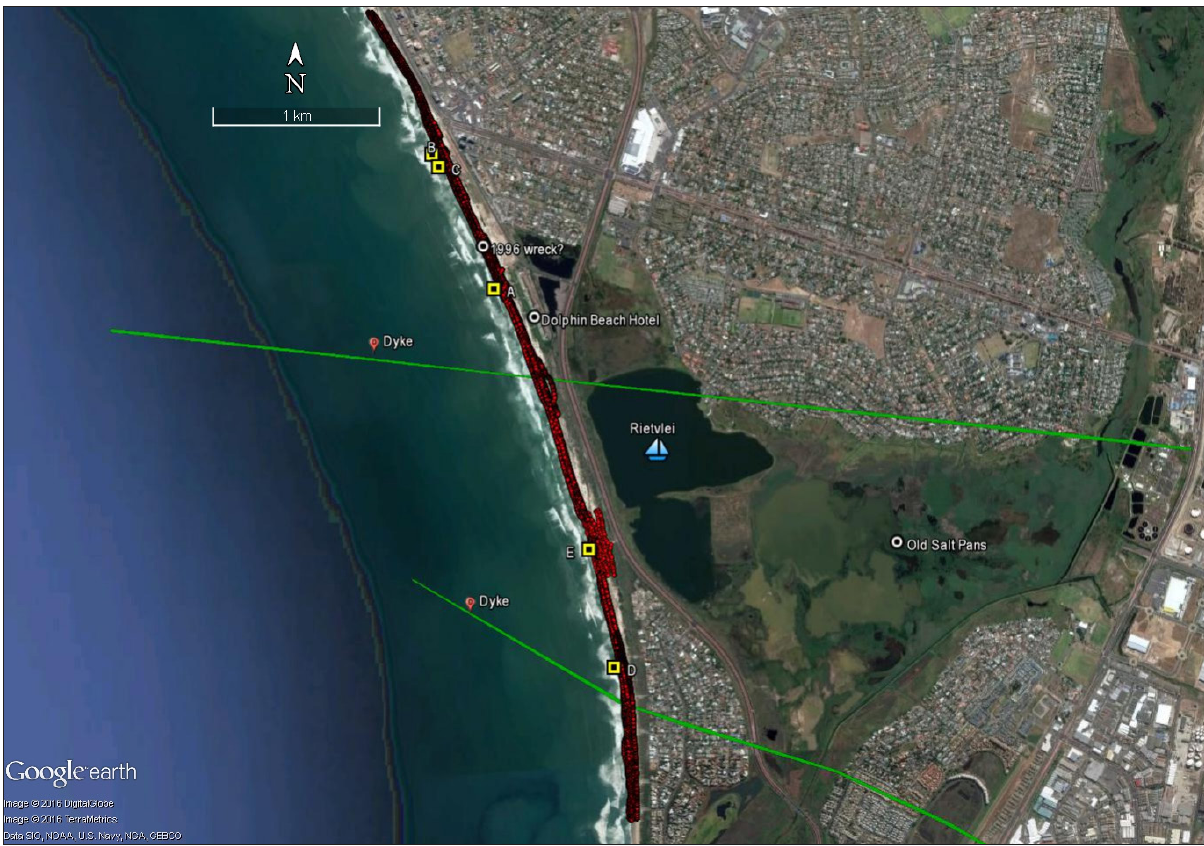
Overview of the search area with five principal targets that need further